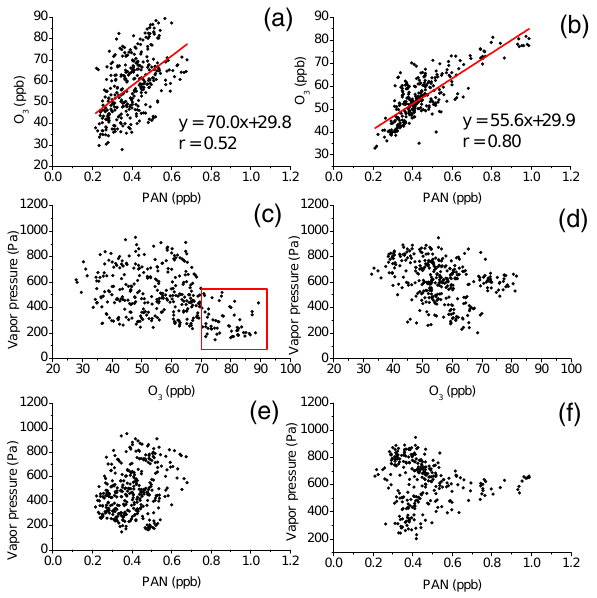
Figure 6. Scatter plots of hourly O 3 versus PAN, vapor pressure versus O 3 , vapor pressure versus PAN of Group 1 (a, c, e) and Group 2 (b, d, f) , following Fig. 4. The correlation shown in (a) and (b) are significant at α = 0.01. The data points within the red rectangle in (c) represent O 3 levels higher than 70ppb and WVP lower than